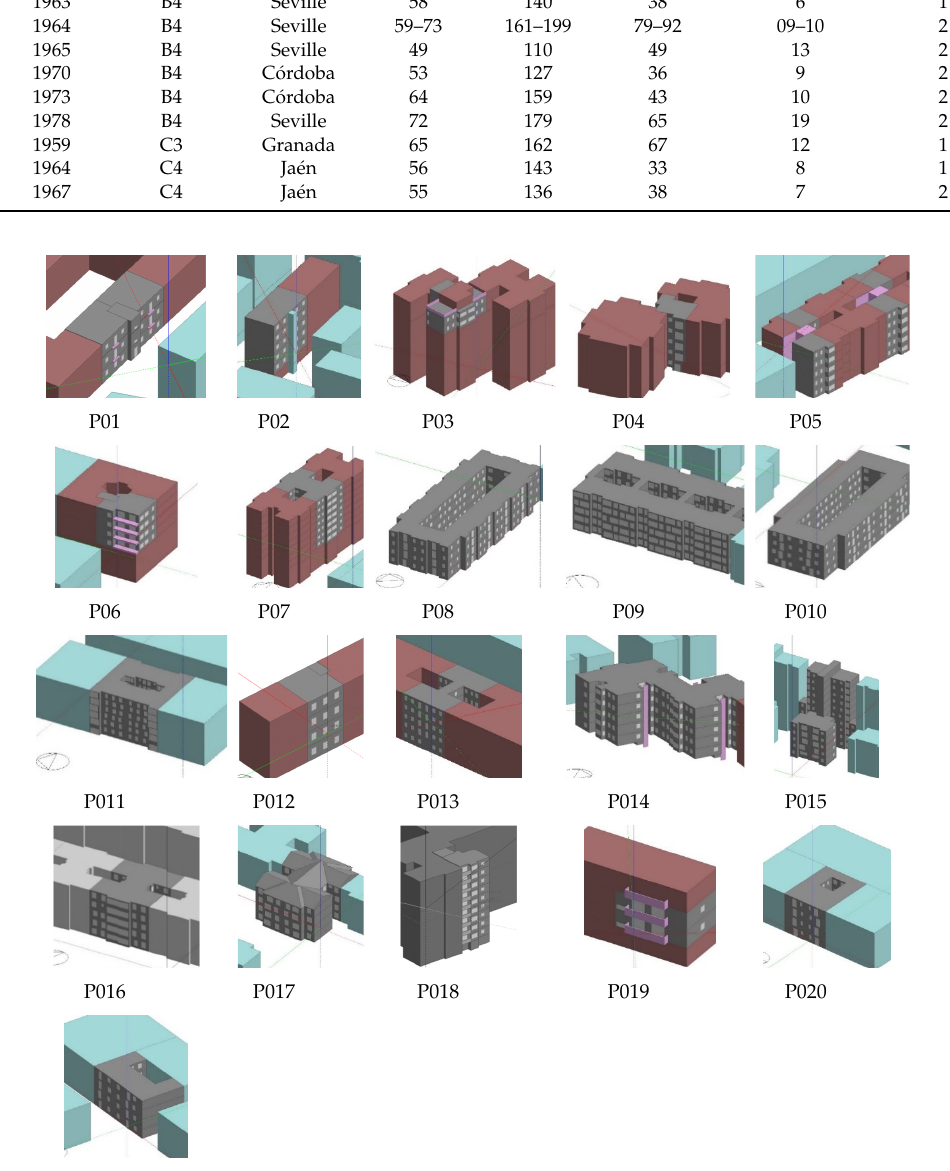
Figure 1. Energy models in the sample studied (Design Builder software).